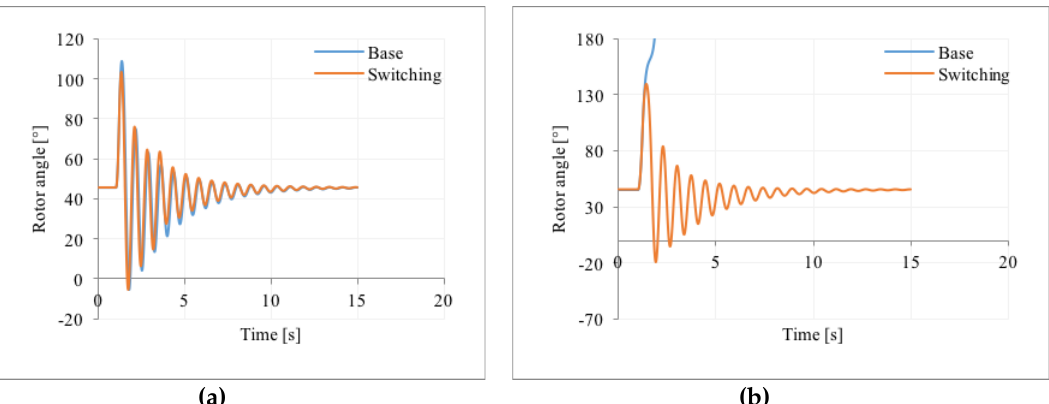
Figure 11. Rotor angle of the synchronous machine of Area 1 for a three-phase fault on Area 2 side: ( a ) Time results for clearing fault time t clear = 170 ms; ( b ) Time results for clearing fault time t clear = 215 ms (critical clearing time t CCT ).